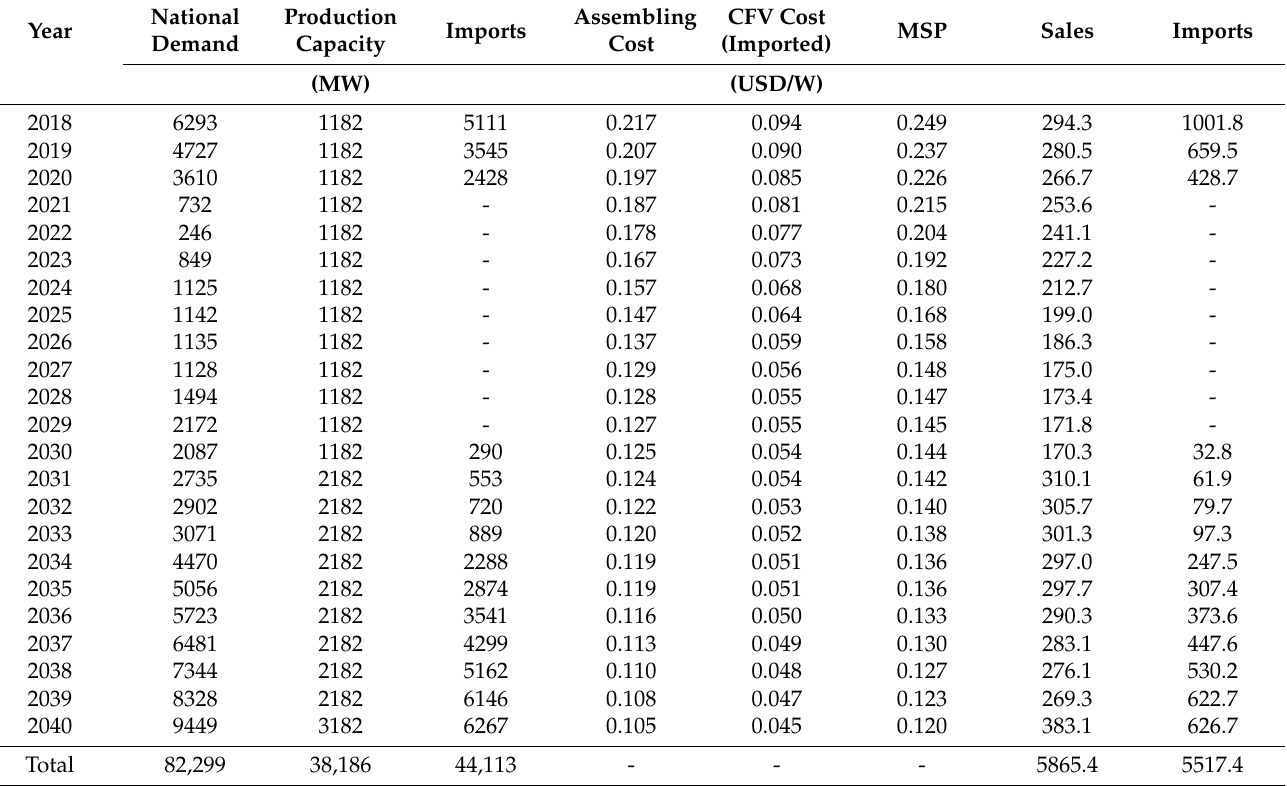
Table 7. Evolution of the VCPVIM production capacity, costs, and prices in the Baseline Scenario,